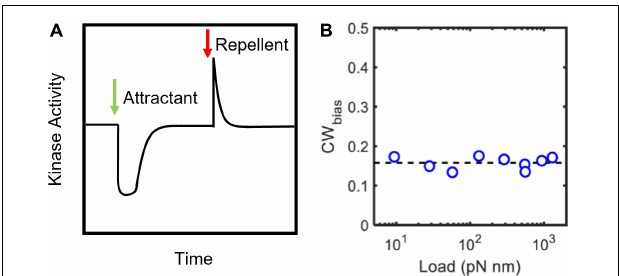
FIGURE 3 | Precise adaptation in chemotactic activity. (A) Cartoon representation of CheA responses to step changes in ligand levels (Sourjik and Berg, 2002). CheA activity was calculated from measurements of Förster resonance energy transfer (FRET) between CheY-eYFP and CheZ-CFP in live cells (Sourjik and Berg, 2002). The addition of an attractant (green arrow) or repellent (red arrow) decreases or increases the kinase activity, respectively. CheR and CheB help adapt the activity precisely to its basal value. Consequently, CheY-P levels and CW bias (not shown) also precisely adapt. (B) The steady-state CW bias is independent of the load (Yuan et al., 2009a; Antani et al., 2021a). This observation suggests that the adaptation of the CW bias to mechanical stimuli (shown in Figure 2B ) is precise. The adaptation is network